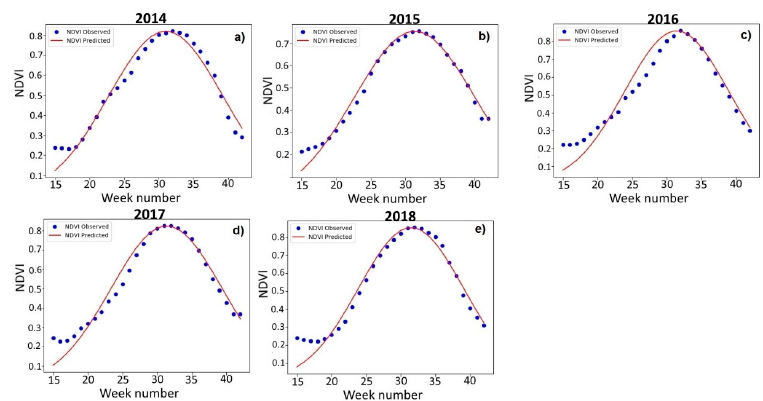
Figure 3. Observed and approximated weekly Normalized Difference Vegetation Index (NDVI) composites (15th–42nd calendar weeks) for the experimental soybean fields in the Khabarovsk District in ( a ) 2014; ( b ) 2015; ( c ) 2016; ( d ) 2017; ( e ) 2018. Table 2. Parameters of the NDVI curves, the maximum NDVI, mean absolute percentage error (MAPE), and root-mean-square error (RMSE) for the experimental soybean fields in the Khabarovsk District in 2014–2018.